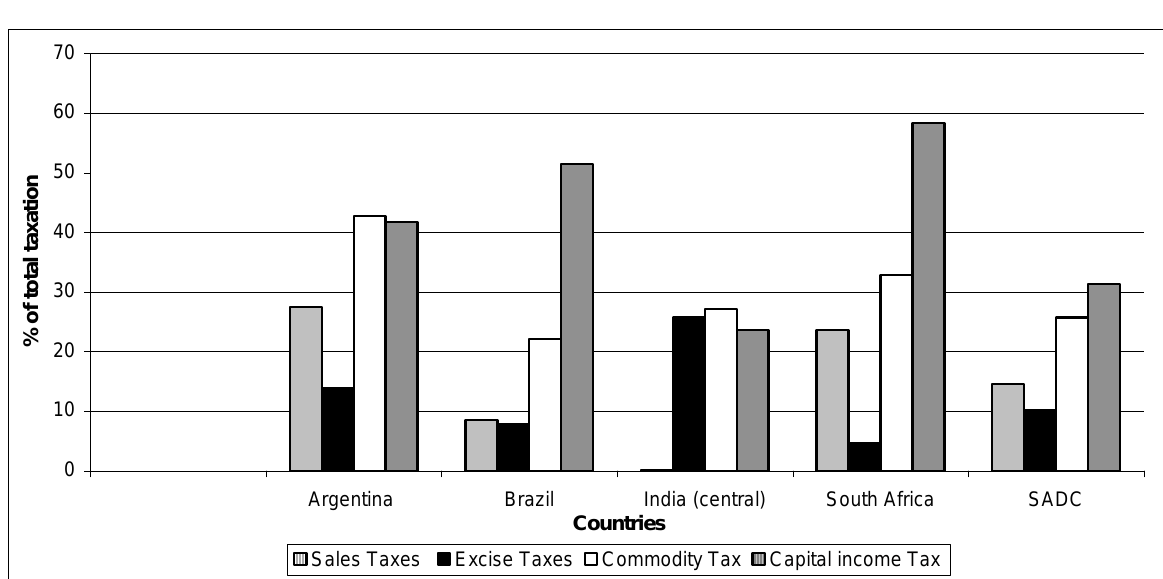
Commodity tax revenue,